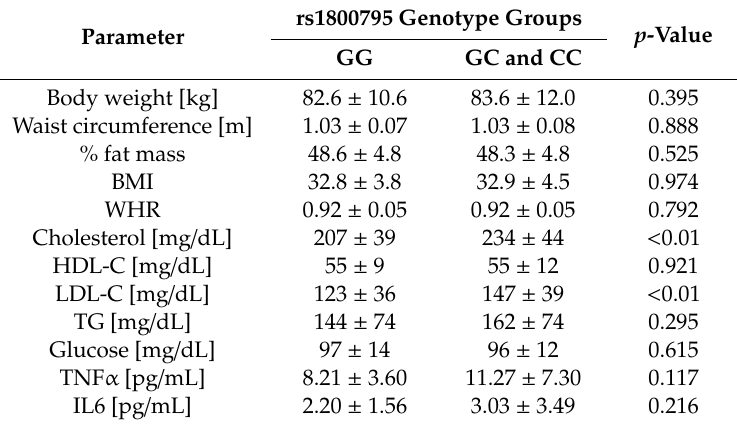
Table 4. Biomarker levels by IL6 variants at